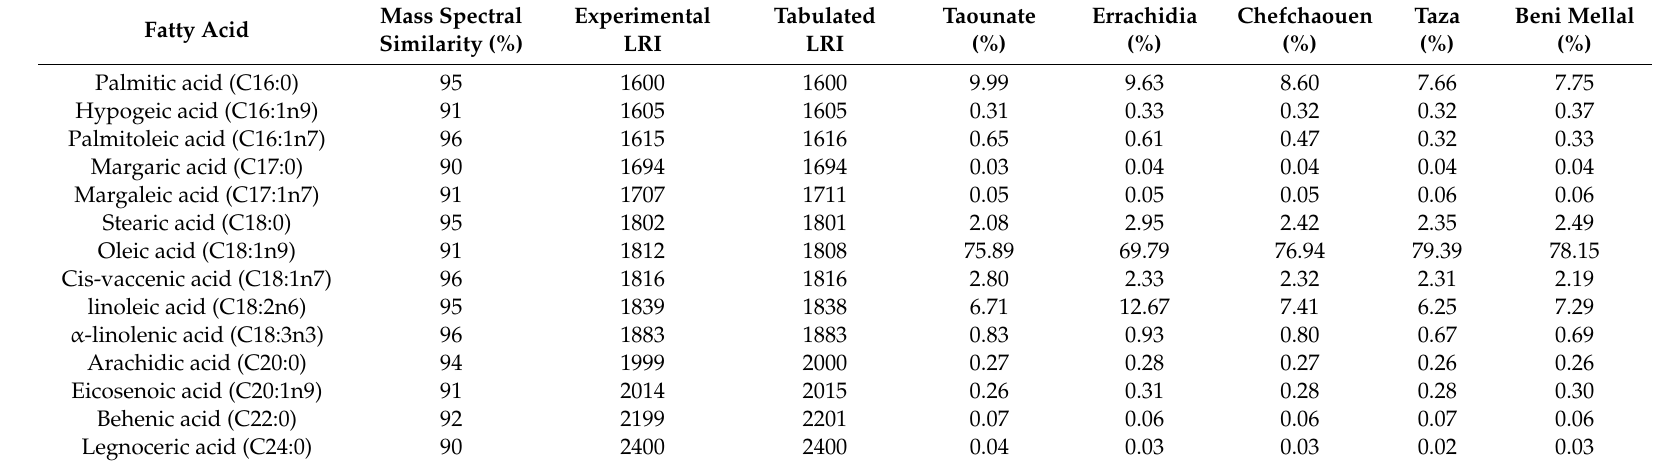
Table 2. Average content of fatty acid methyl ester extractions (FAMEs) in VOOs of Picholine marocaine collected from the five provinces studied. Fatty